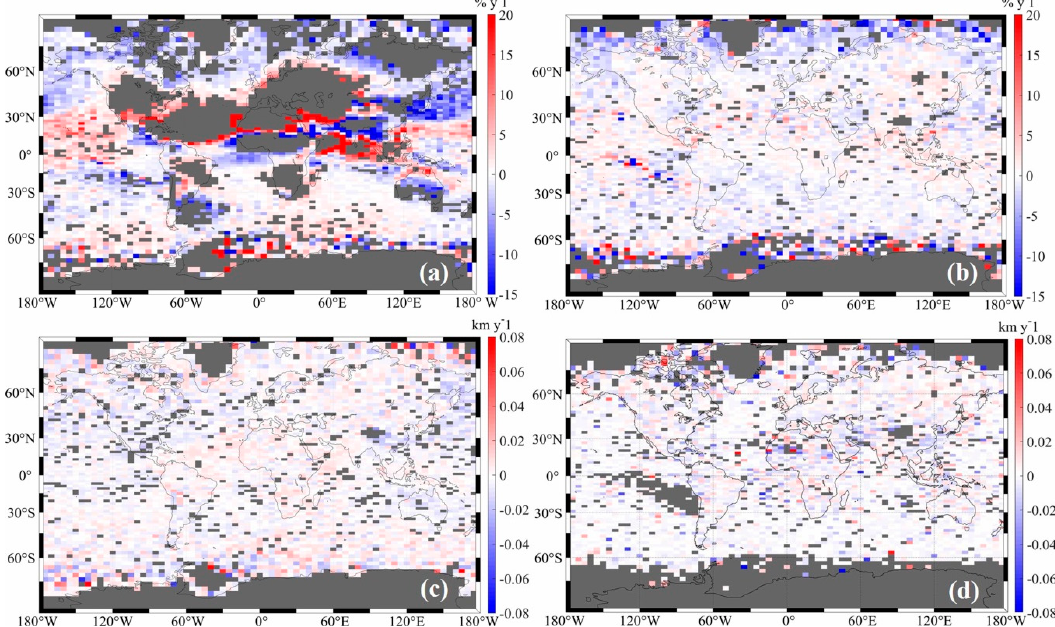
Figure 9. Spatial distribution in long-term rates of changes in absorbing aerosol MFA and MFNC values from 2007 to 2016. ( a ) The rates of change in MFNC for dust; ( b ) The rates of change in MFNC for smoke; ( c ) The rates of change in MFA for dust; ( d ) The rates of change in MFA for smoke. Gray shading indicates no data or failure of the significant test ( ≥ 95% confidence level). Note, scales of color bars are different from each other.